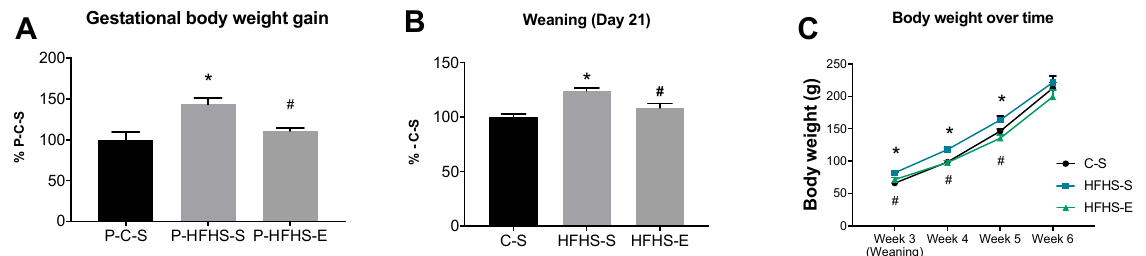
Figure 1. Gestational body weight gain of dams during pregnancy ( A ); offspring body weight at 21 days of age ( B ); and offspring body weight from weaning until 6 weeks of age ( C ). Control sedentary dams (P–C–S); high-fat, high-sucrose sedentary dams (P–HFHS–S); high-fat, high-sucrose exercised dams (P–HFHS–E); offspring from control diet sedentary group (C–S); offspring from high-fat, high-sucrose diet sedentary group (HFHS–S); offspring from high-fat, high-sucrose diet exercised group (HFHS–E), n = 6. Data are expressed as the mean ± SEM. Statistically significant differences ( p ≤ 0.05) are indicated as follows: * vs. C–S, # vs. HFHS–S.